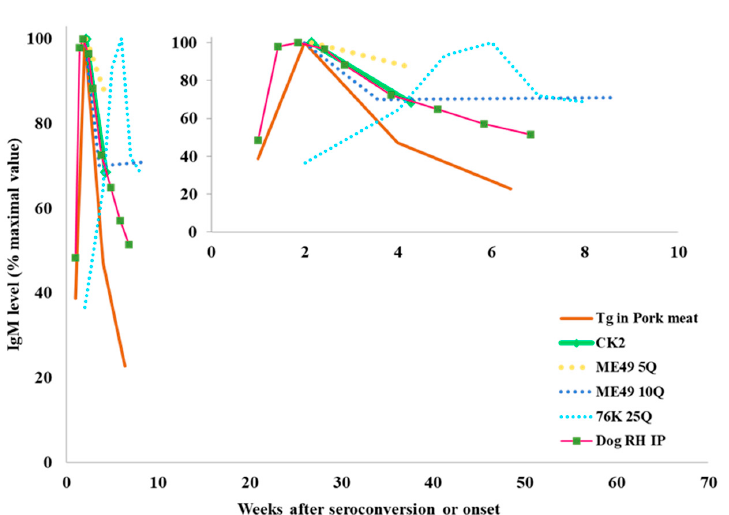
Figure 6. Kinetics of anti- T. gondii- reacting IgM antibody levels in animal groups experimentally infected. The large graphic shows the kinetics until 70 weeks in order to compare with human cases.